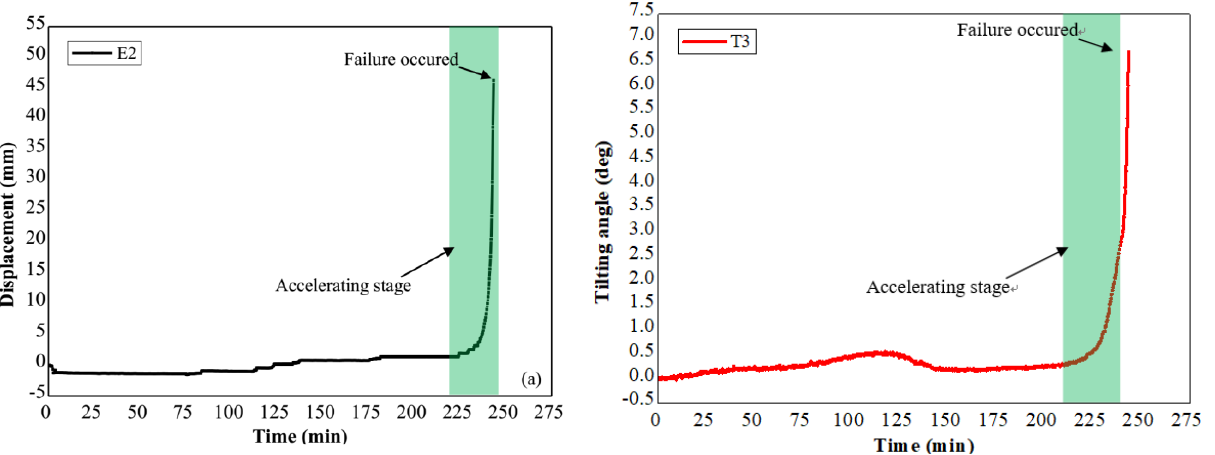
Figure 11. ( a ) Time history of the displacement at subsurface in Field Test 1, ( b ) time series of the tilting angle at the subsurface in Field Test 1.